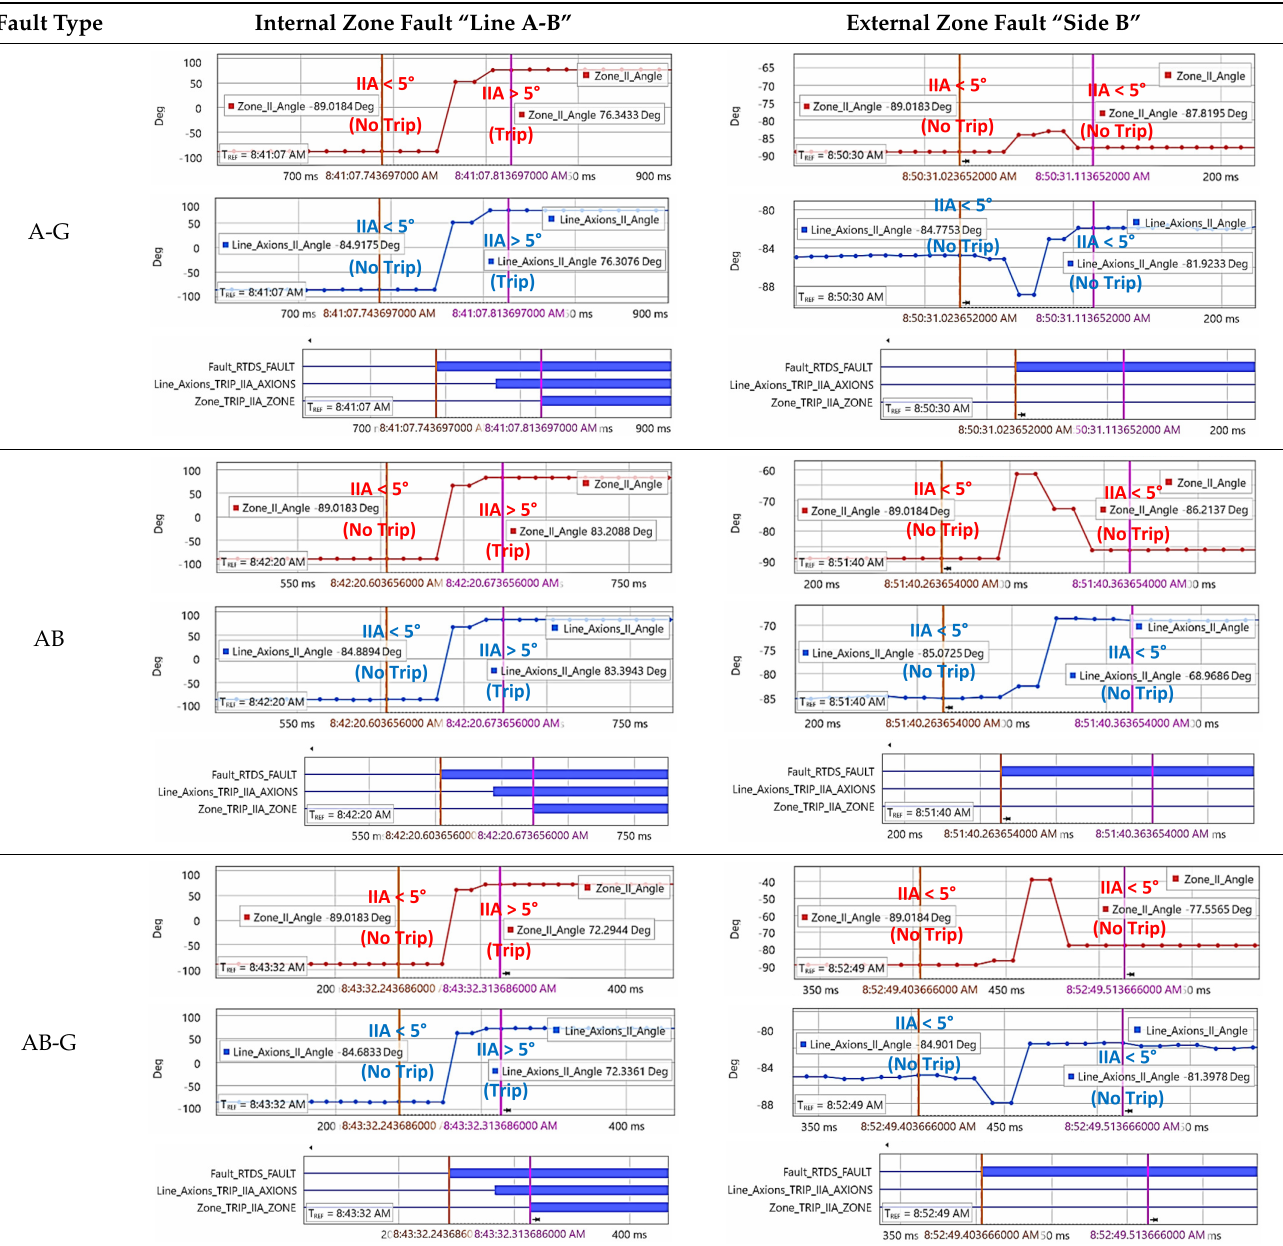
Table 6. IIA Zone behaviour without RES (Part 1 of